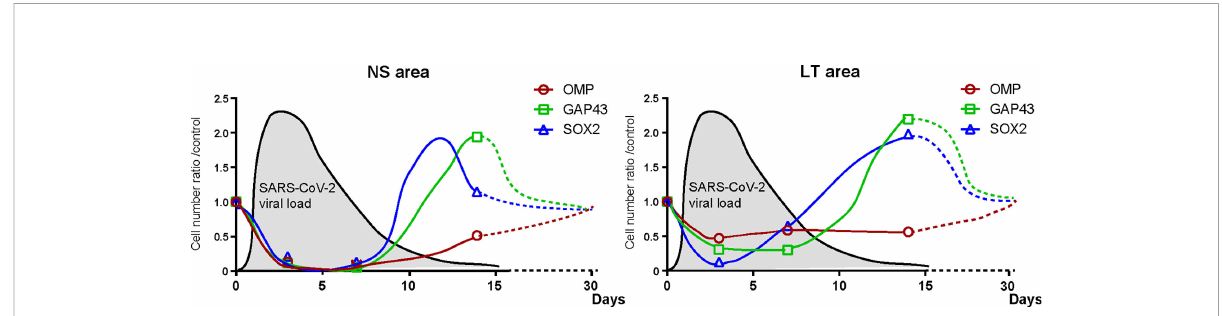
FIGURE 6 Hypothesis of temporal changes in the SARS-CoV-2 viral load in the lungs and the number of olfactory receptor neuron-related cells in different nasal areas. Changes over time in the ratio of the number of olfactory receptor neuron lineage cells divided by that of the control group at each time point are displayed in the graph. The dashed line shows the speculated future trend. In addition, the estimated viral load of SARS-CoV-2 in the lungs is overlaid on each graph. NS, nasal septum; LT, lateral turbinate; OMP, OMP + mature olfactory receptor neurons; GAP43, GAP43 + immature olfactory receptor neurons; SARS-CoV-2, severe acute respiratory syndrome coronavirus 2; SOX2, SOX2 + olfactory